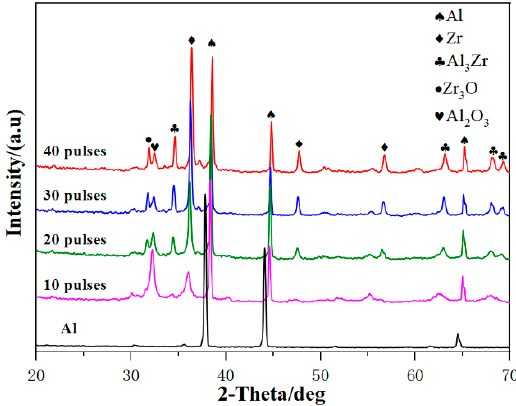
Figure 1. The XRD analysis of the samples before and after alloying.